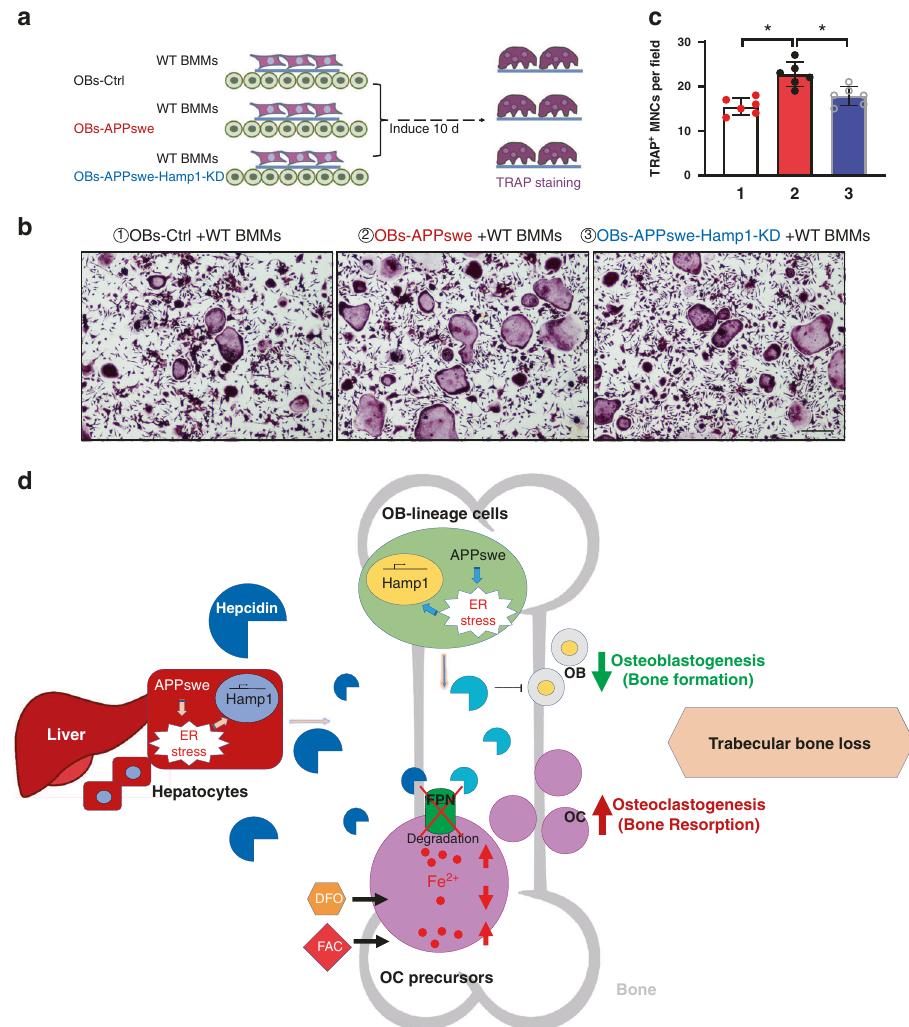
Fig. 7 Hepcidin partially rescues the increase in osteoclastogenesis in the OB-APPswe-BMM coculture system. a Experimental strategy. b TRAP staining of OCs cocultured with OBs. Bar, 200 μ m. c Quanti fi cation of TRAP + MNCs per fi eld in ( b ). The data are presented as the mean ± SD of six different coculture experiments. * P < 0.05. d Illustration of the working model. Hepcidin expression in hepatocytes or OB lineage cells induced by APPswe-driven ER stress increases osteoclastogenesis, which appears to be due to its role in downregulating FPN expression- mediated iron export in macrophages and thus increasing intracellular iron levels, proliferation of OC precursors, and OC differentiation. AD is one of the most serious neurodegenerative disorders, and patients with AD commonly have increased bone fracture rates and reduced bone density. 1,2 APPswe has been found to suppress OB differentiation and promote OC differentiation in mouse models, such as the Tg2576 mouse model; however, the mechanisms underlying the association between APPswe and these processes remain poorly understood. 9,15,16 Previously, we demonstrated that A β -RAGE signaling in OC precursor cells appears to be one of the critical pathways underlying age- dependent OC formation and activation in Tg2576 mice. 15 Here, we provide several lines of evidence that hepcidin in OB lineage cells not only inhibits OB-mediated bone formation but also promotes OC-mediated bone resorption, revealing another path- way underlying APPswe-induced bone loss. First, hepcidin expression is increased in the sera of Tg2576 mice and TgAPPswe-Ocn mice (Figs. 1c – g and 6a), and both mouse lines